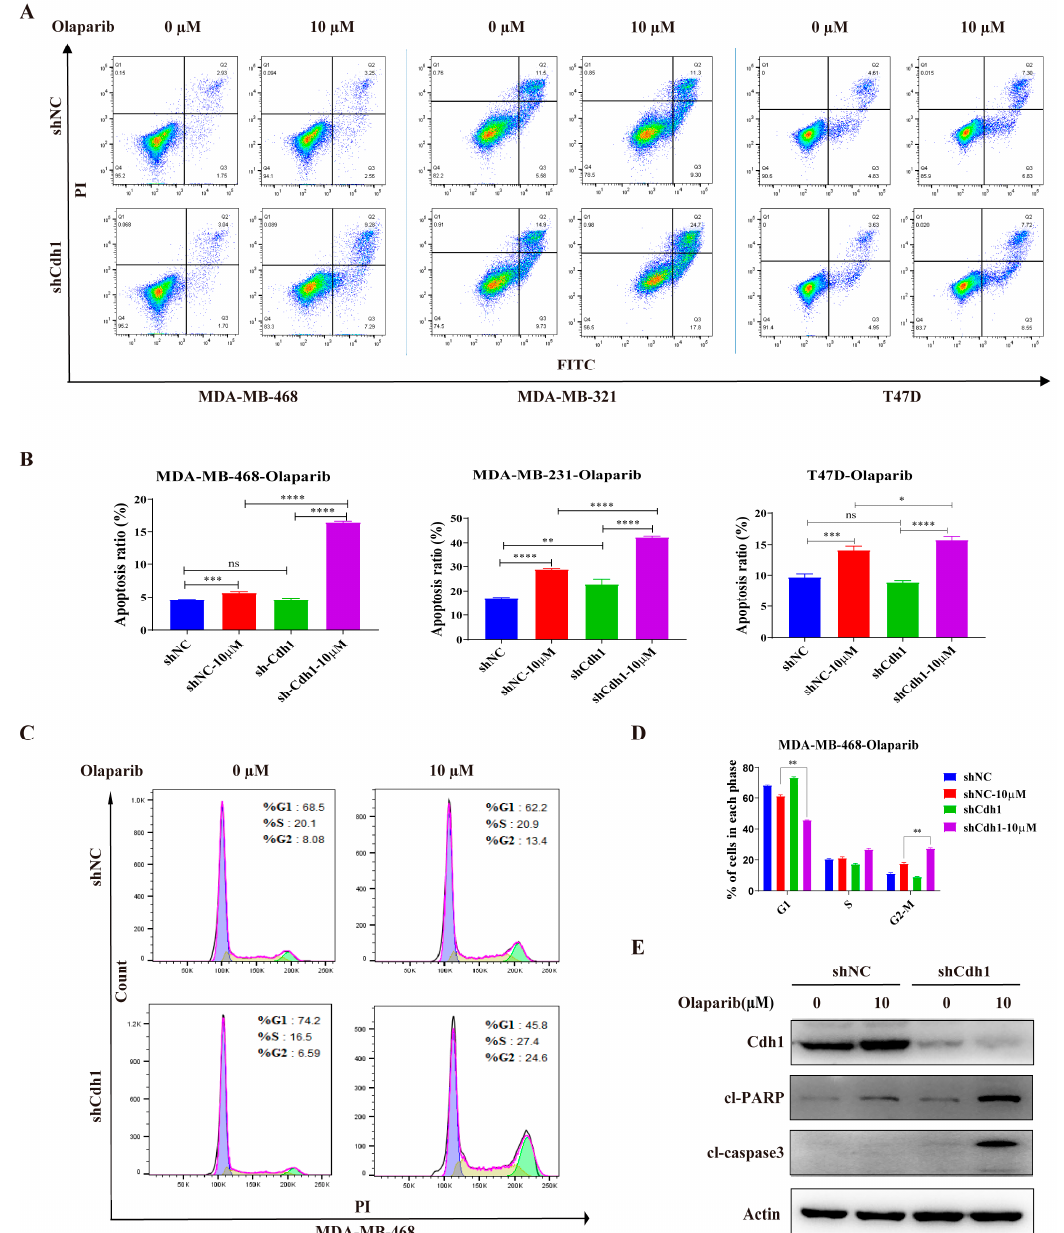
Figure 3. Cdh1 depletion induces apoptosis and G2-M arrest in TNBC cells following PARPi. ( A ) Flow cytometry analysis showing apoptosis of MDA-MB-468, MDA-MB-231 and T47D cells transduced with scrambled shRNA (NC) or shRNA against Cdh1 in in response to Olaparib (0 µ M and 10 µ M) for 96 h; ( B ) the percentage of apoptotic cells were quantified. Data are means of at least three independent experiments. Apoptosis rate was the sum of the two quadrats on the right in each FACS figure. Error bars indicate S.E.M. Significance of differences was calculated using Student’s t test (* p < 0.05, ** p < 0.01, *** p < 0.001, **** p < 0.0001; ns: p ≥ 0.05); ( C ) flow cytometry analysis showing cell cycle distribution of MDA-MB-468 cells transduced with scrambled shRNA (NC) or shRNA against Cdh1 in response to Olaparib (0 µ M and 10 µ M) for 96 h; ( D ) quantification of cell cycle distribution. Data are means of at least three independent experiments. Error bars indicate S.E.M. Significance of differences was calculated using Student’s t test (** p < 0.01; ns: p ≥ 0.05); ( E ) Western blotting analysis the expression of Cdh1, cl-PARP and cl-Caspase 3 in MDA-MB-468 cells transduced with scrambled shRNA (NC) or shRNA against Cdh1 in response to olaparib (0 µ M and 10 µ M) for 96